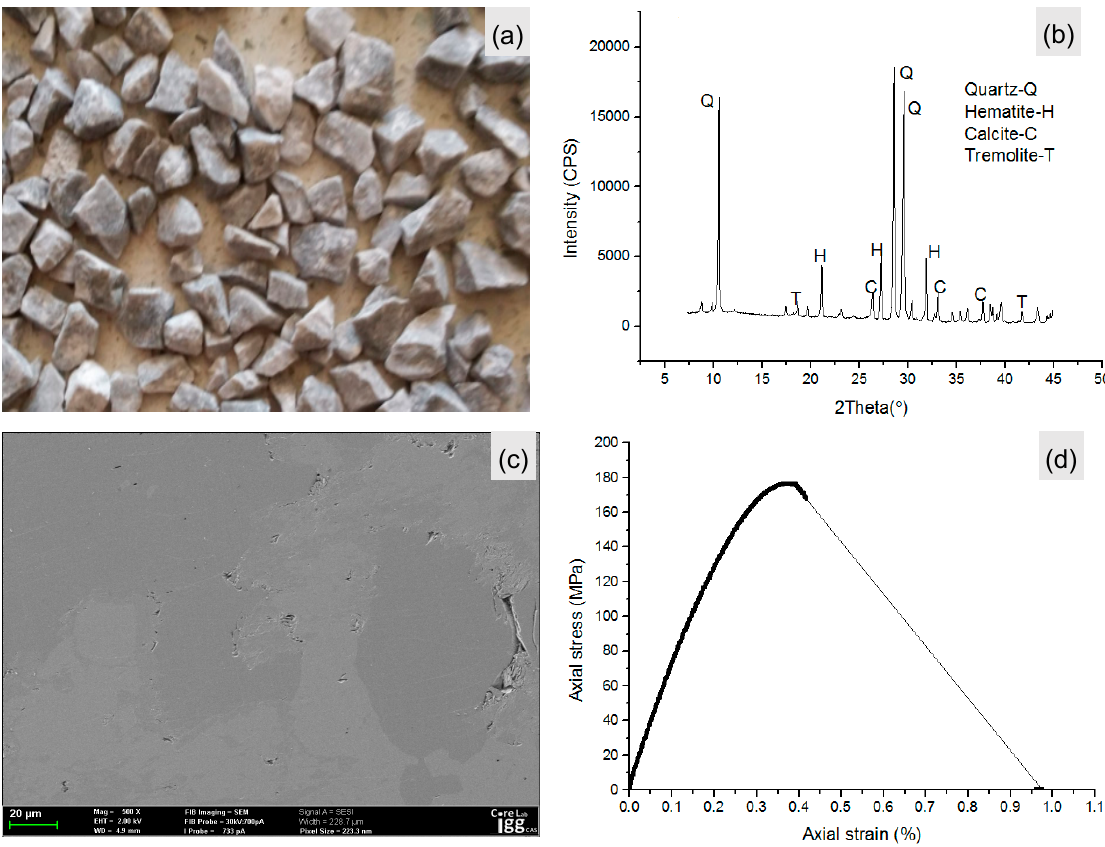
Figure 3. The waste rock blocks used in the preparation of the CWRTB samples. ( a ) The waste rock pieces used in the preparation of CWRTB samples; ( b ) the XRD results; ( c ) the SEM results; ( d ) the stress–strain curve of the marble block under uniaxial compression with a sample size of 50 mm in diameter and 100 mm in height. Tested according to ASTM standards.